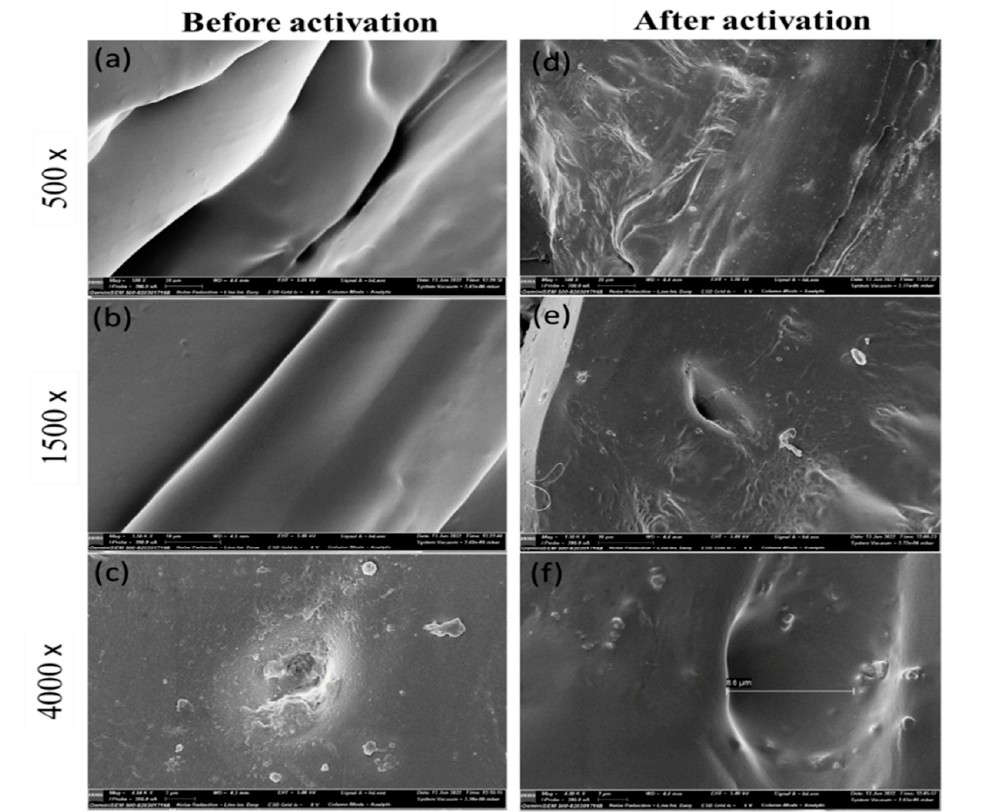
Figure 3. SEM image of 3D FFF printed sorbent. Before activation ( a – c ) and activated sorbent after rinsing with water ( d – f ).